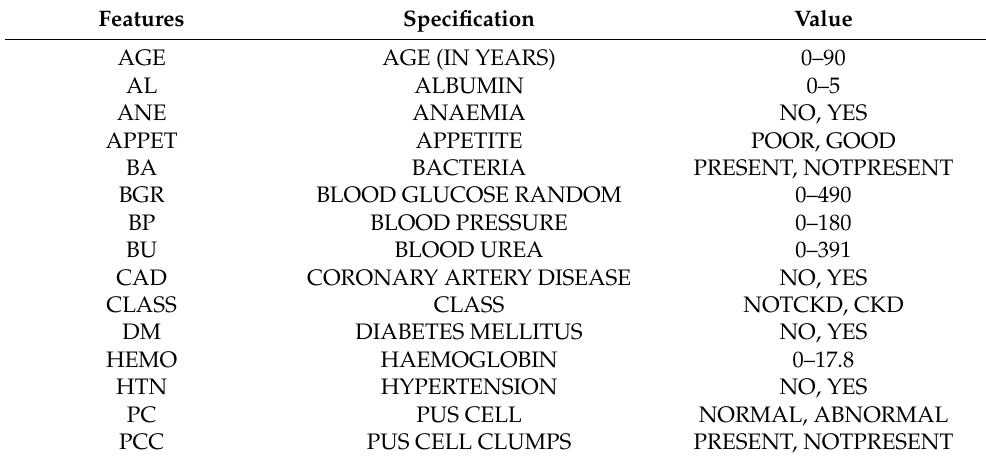
Table 2. Characteristics of the UCI CKD